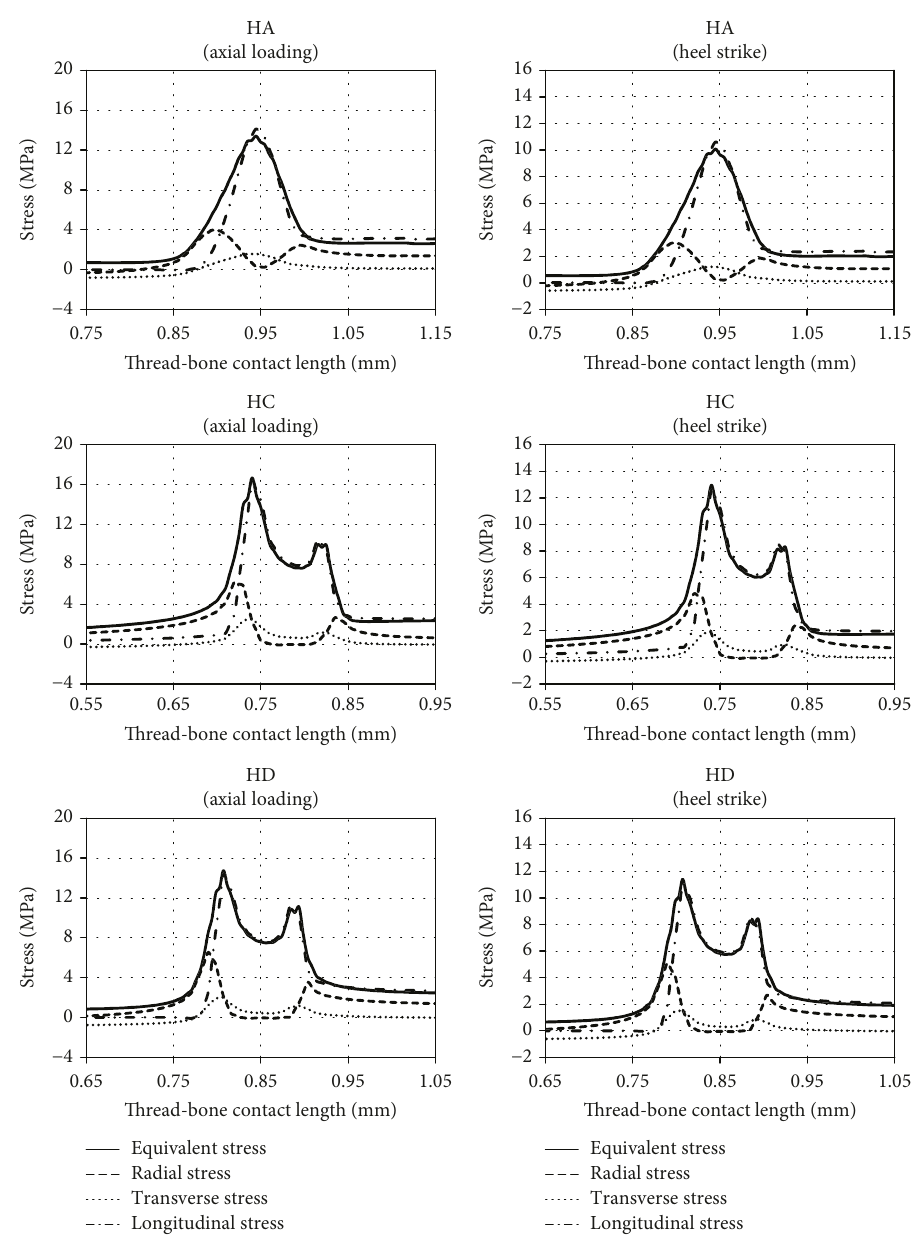
Figure 6: Individual stress pro fi les at the thread-bone interface during di ff erent loading types — the pro fi le was limited to the section of stress peak formation (above and below of the presented values of the thread-bone contact length the stress pro fi le changed